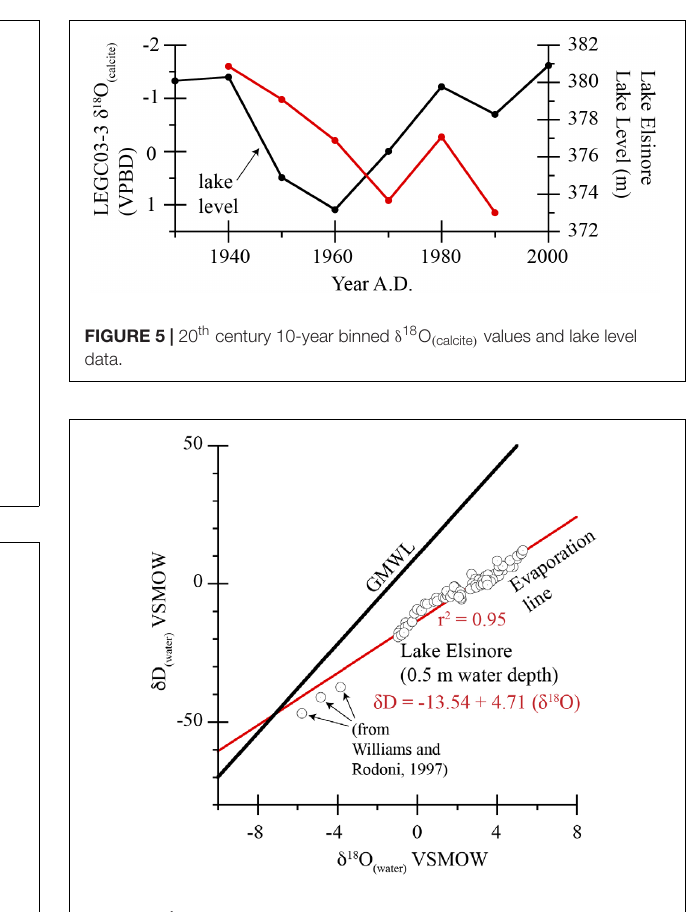
samples, range from a minimum of 9.4 ◦ C to a maximum of 28.9 ◦ C with a mean of 20.3 ◦ C ( n = 77) ( Figure